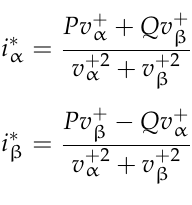
Figure 8. A simple multi-loop control structure for the primary validation of the current